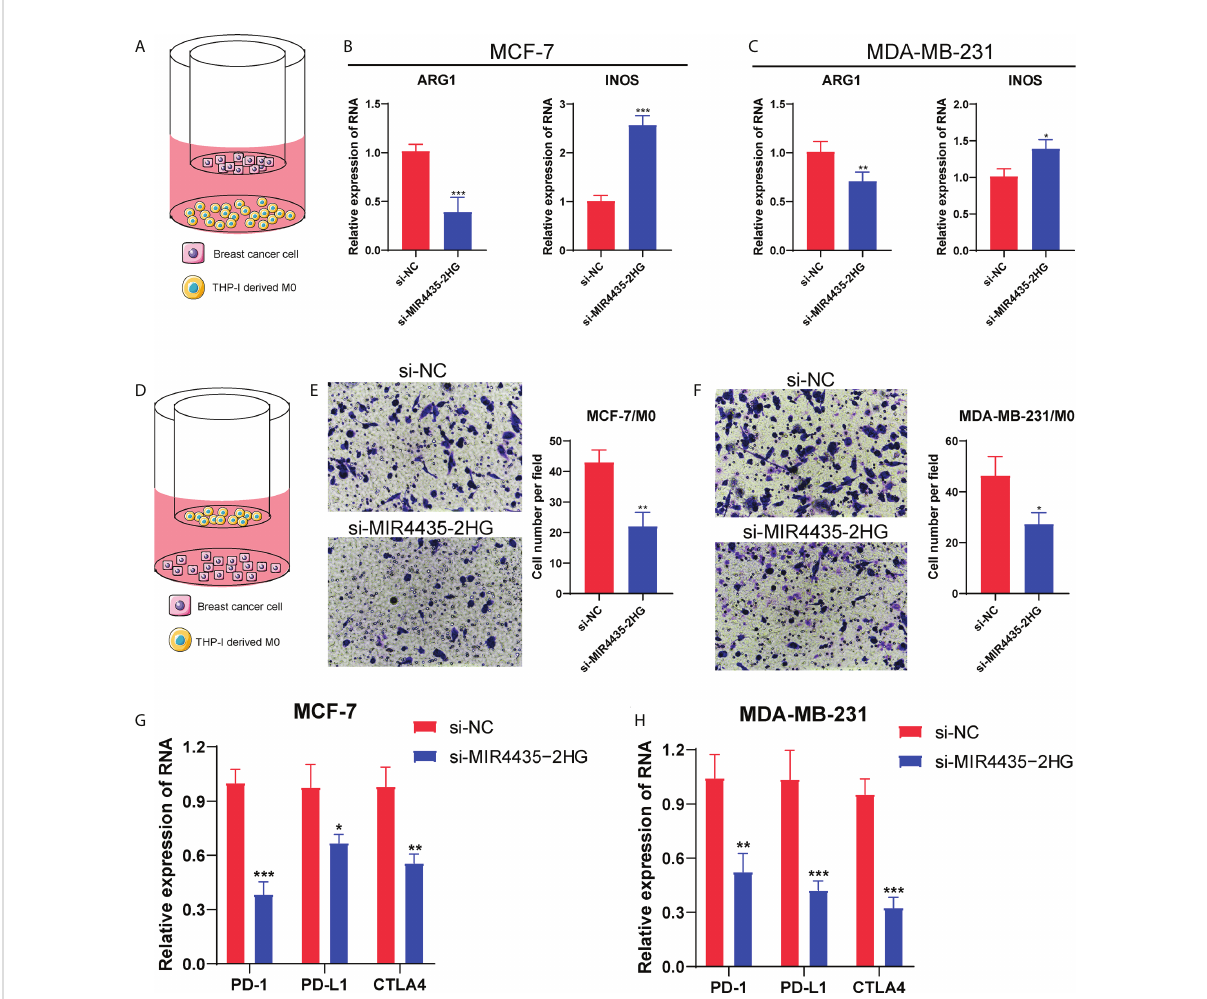
FIGURE 10 MIR4435-2HG affected macrophage polarization and PD-1/PD-L1/CTLA4 expression. The diagram for the co-culture between BC cells and THP-1-derived M0 macrophages (A, D) . The mRNA levels of ARG1 and iNOS in MCF-7 (B) and MDA-MB-231 cells (C) . (E, F) The transwell assay showing the migrated ability of macrophages after co-cultured with si-MIR4435-2HG BC cells. (G, H) The mRNA level of PD-1/PD-L1/CTLA4 in BC cells after MIR4435-2HG knockdown. *P < 0.05; **P < 0.01; ***P <